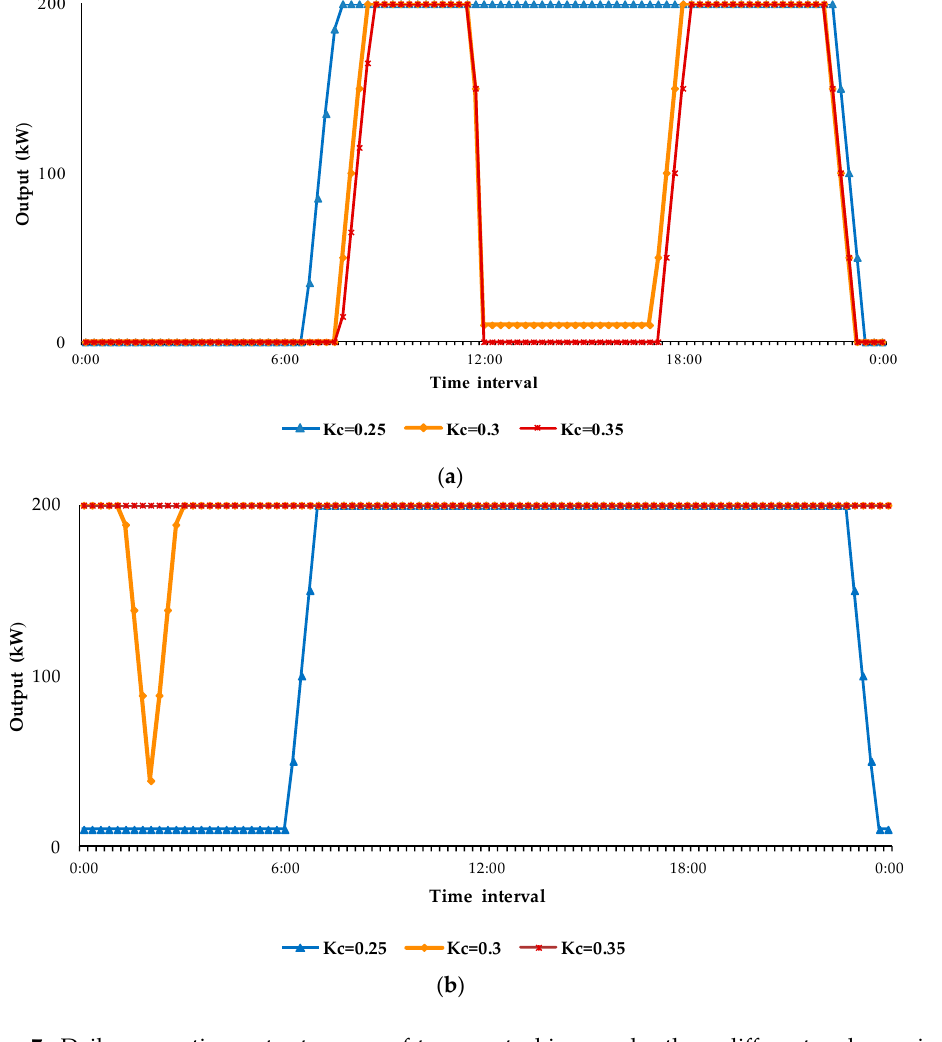
Figure 7 . Daily generation output curves of two gas turbines under three different carbon prices. ( a ) Gas turbine 1; ( b ) Gas turbine 2.